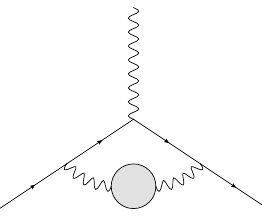
Figure 1. The topology of the leading hadronic contribution to the anomalous magnetic moment of the muon, hadronic vacuum